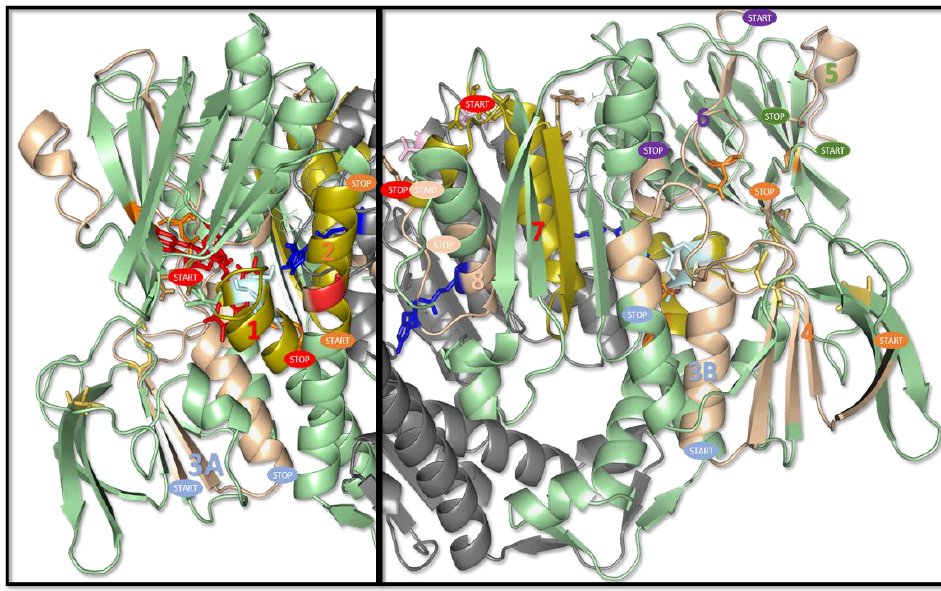
Figure 6. Maps of the detected peptides on the human DLD structure. Each peptide is labelled with its own number and its start and stop position. Peptides 1, 2 and 7 are highlighted in gold.